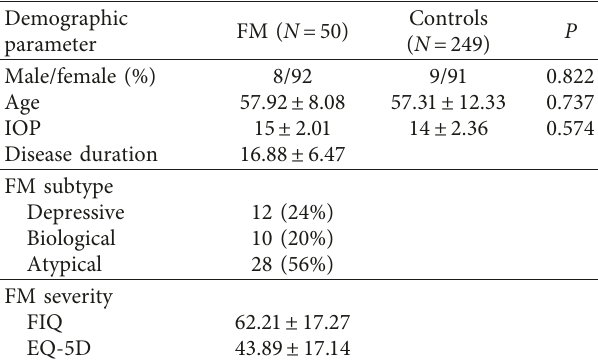
Figure 1: Vasculature analysis was obtained using the Triton (Topcon, Japan) SS-OCT angiography in a healthy subject included in the study. The vascular plexus can be displayed at different ocular levels: superficial (a), deep (b), outer retina (c), and choriocapillaris (d). Table 1: Demographic parameters of patients with fibromyalgia and healthy controls included in the